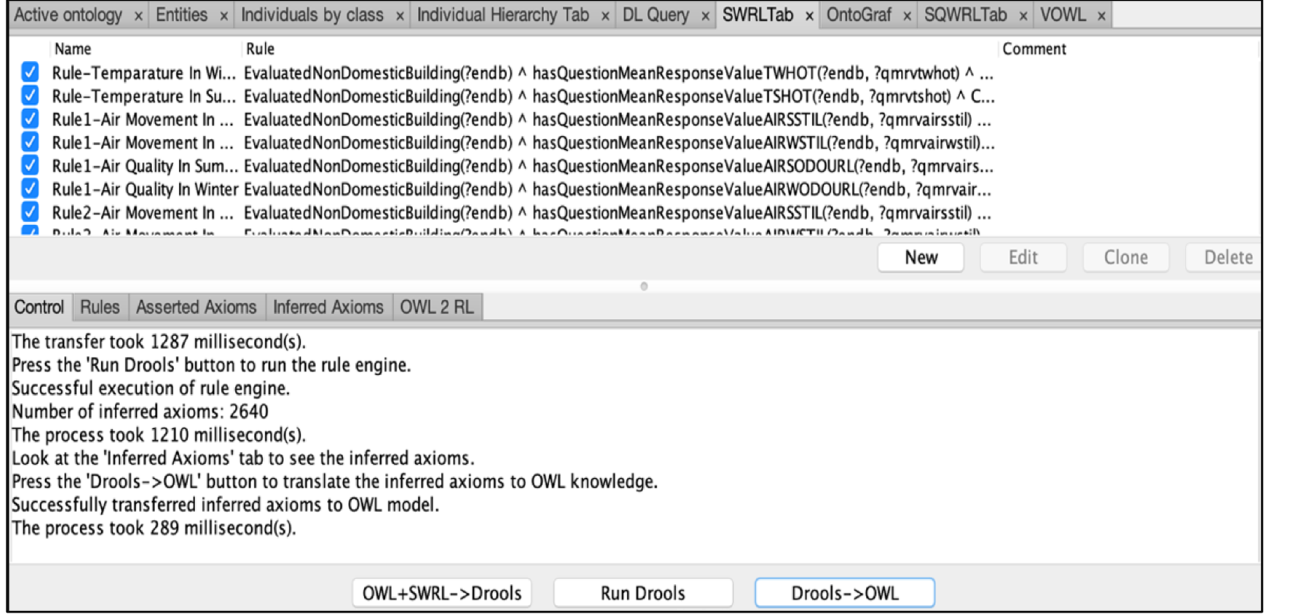
Fig. 7. Reasoning engine.